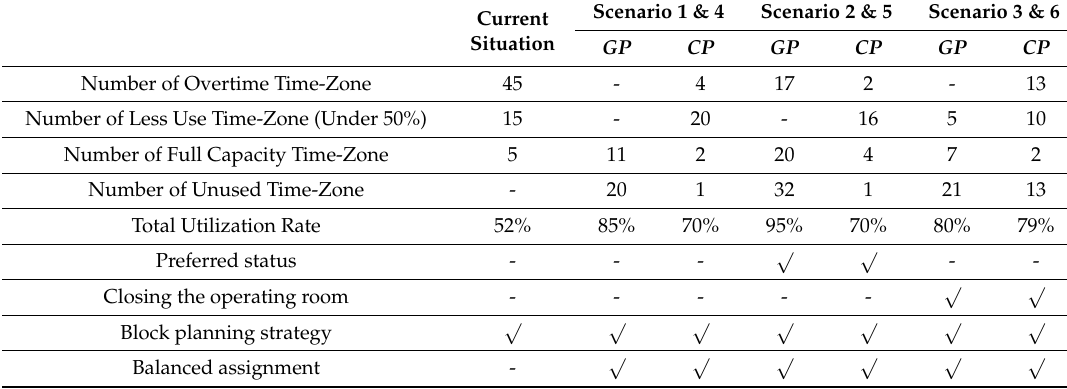
Table 8. Summary of current situation and